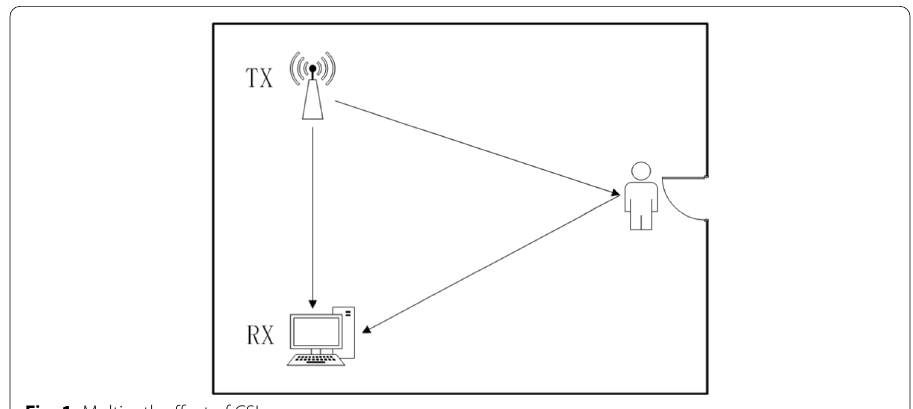
Fig. 1 Multipath effect of